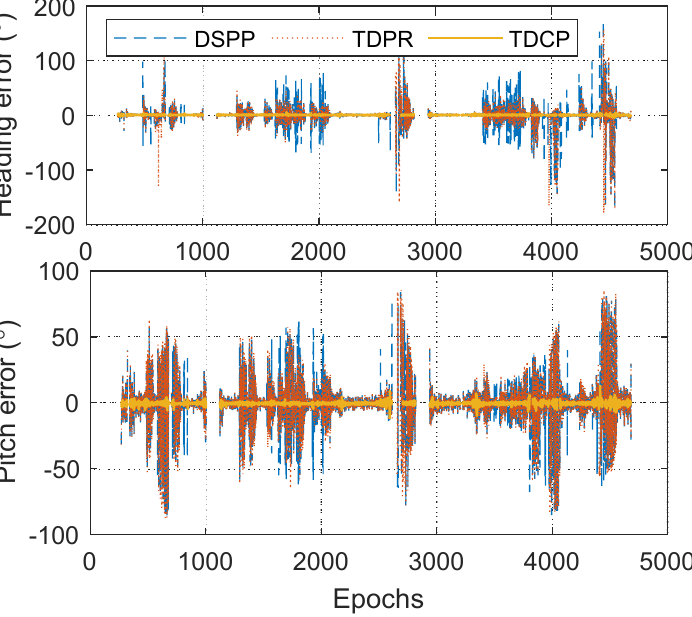
Figure 14. Attitude errors of the heading (top) and pitch (bottom) estimates of three different algo- rithms.